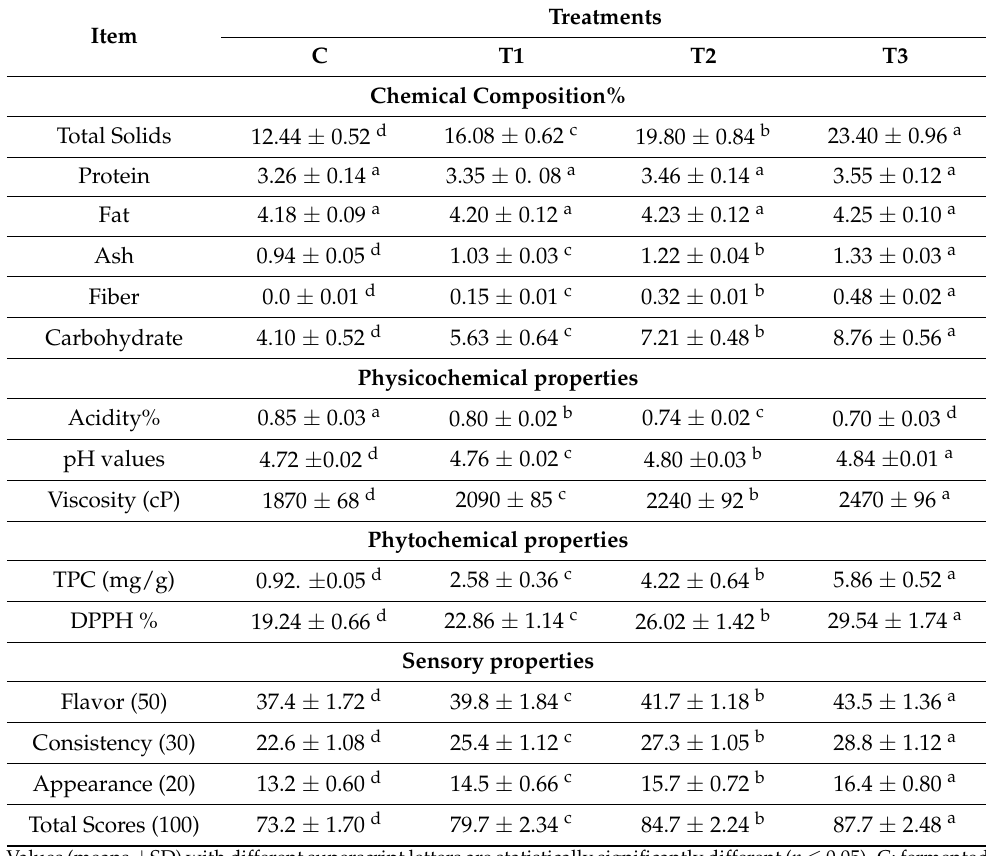
Table 2. Chemical composition, physicochemical, phytochemical, and sensory properties of fer- mented camel milk supplemented with sidr fruit